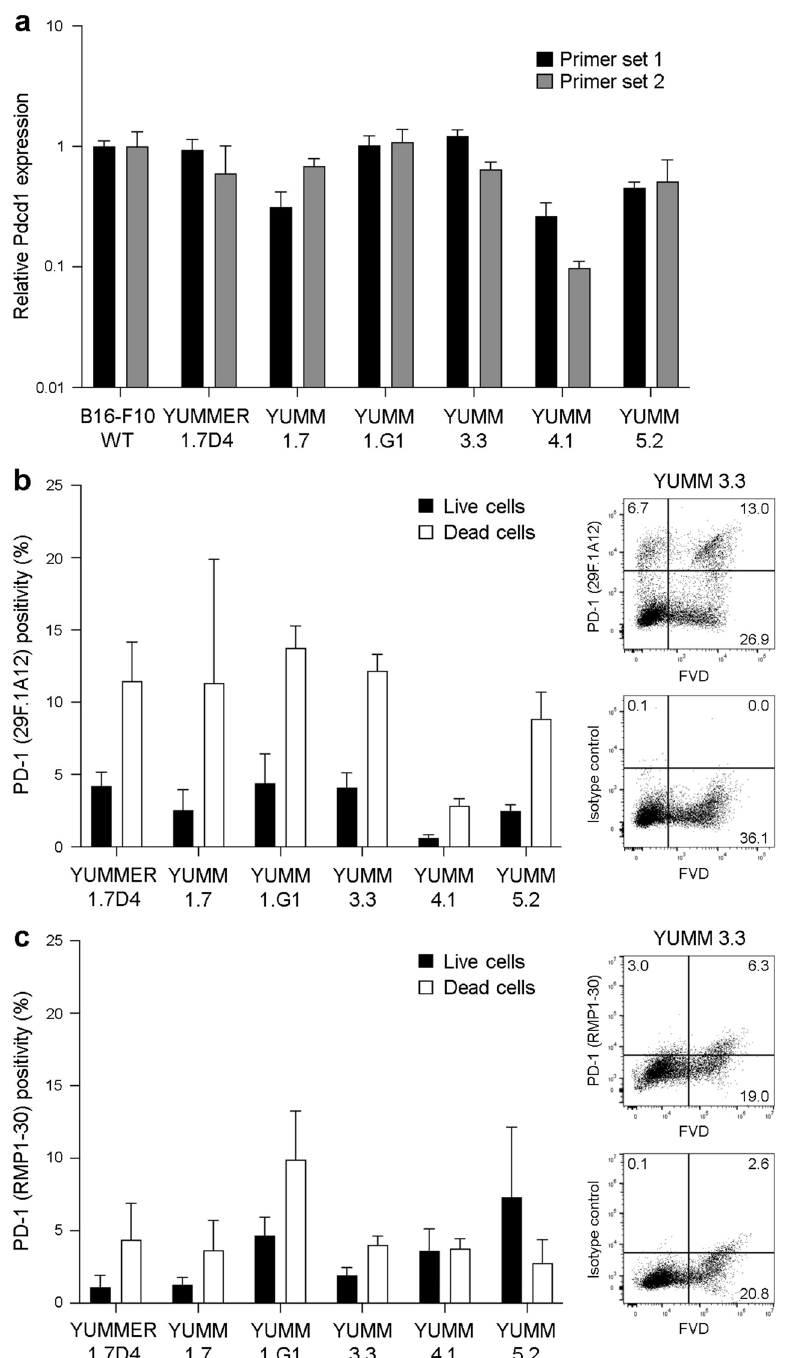
Figure 4. The anti-PD-1 29F.1A12 and RMP1-30 antibody clones recognize PD-1 surface protein on live YUMM melanoma cells. ( a ) Relative PD-1 gene ( Pdcd1 ) expression (mean ± s.d., two distinct primer sets) in wild-type B16-F10, YUMMER1.7D4, YUMM1.7, YUMM1.G1, YUMM3.3, YUMM4.1, and YUMM5.2 cells. ( b,c ) Representative FACS plots (YUMM3.3) of surface PD-1 protein expression (clones 29F.1A12 and RMP1- 30, respectively) or isotype control staining and % positivity (mean ± s.e.m.) on live versus dead (fixable viability dye, FVD-negative or -positive, respectively) YUMM melanoma cell lines, as in ( a